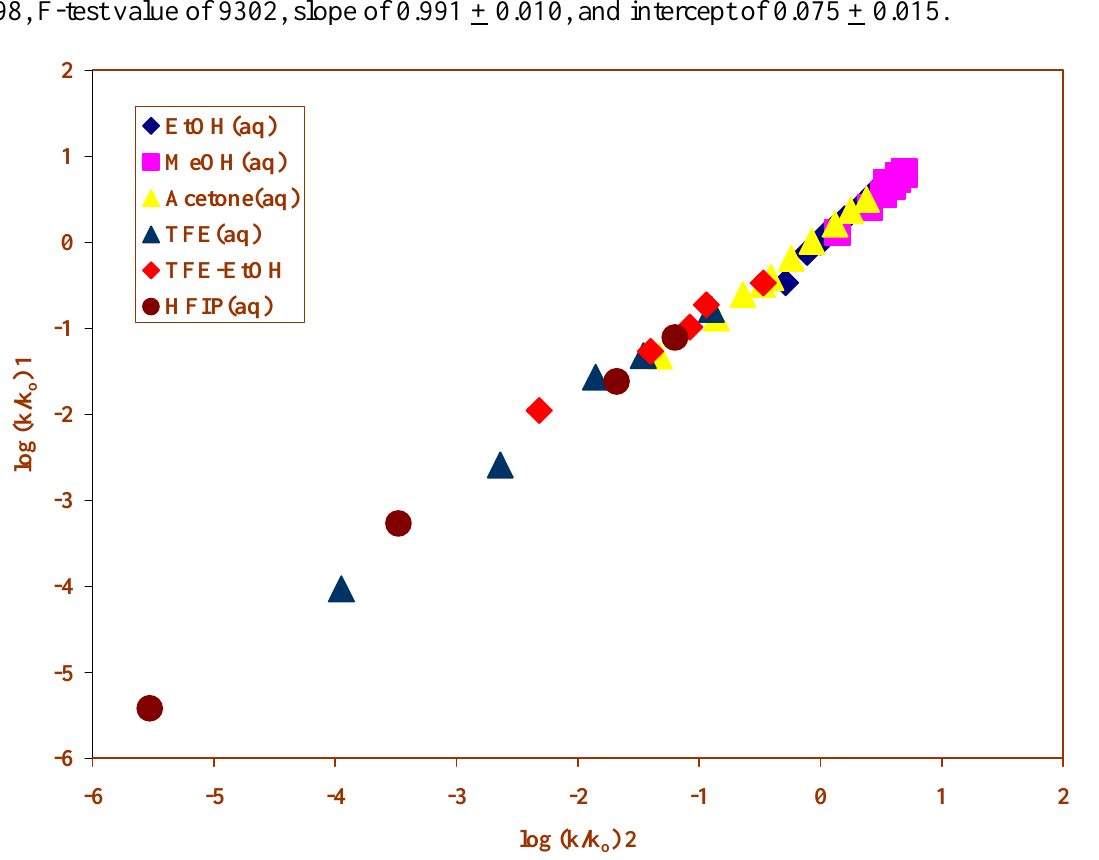
Figure 2 . The plot of log (k/k ) for p -methoxyphenyl chloroformate ( 1 ) against log (k/k o chloroformate ( 2 ) in pure and binary solvents at 25.0